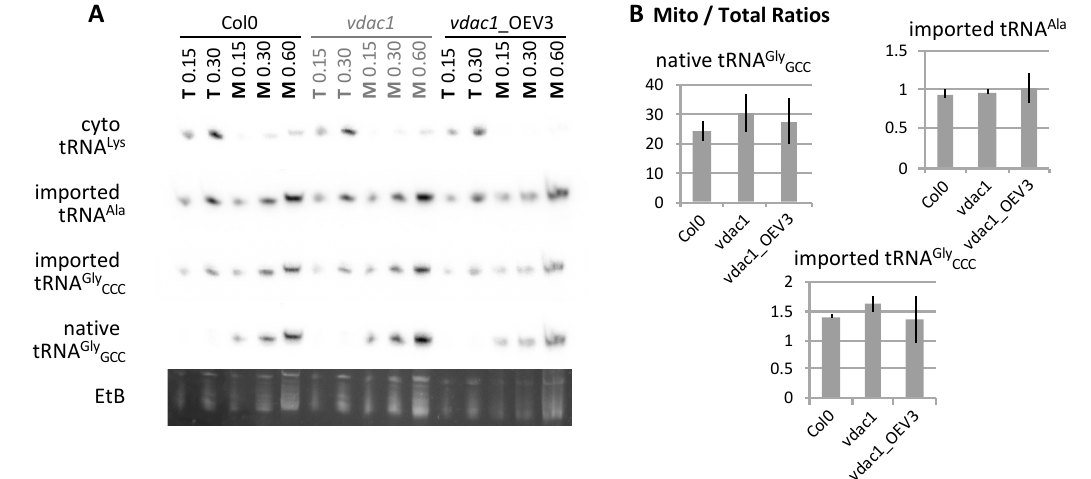
Figure 2. In vivo import of tRNAs into mitochondria. Mitochondria were extracted from Col0, vdac1 and vdac1 _OEV3 seedlings. Total (T) and mitochondrial (M) tRNAs were prepared and loaded onto a urea-polyacrylamide gel (0.15–0.60 µ g). ( A ) Northern blots. Four tRNA probes were used. The native tRNA Gly corresponds to a mitochondrial-encoded tRNA. The tRNA Ala and tRNA Gly CCC are nuclear-encoded and imported into mitochondria. The tRNA Lys is nuclear-encoded, but restricted to the cytosol [24]. This last probe shows that the level of cytosolic contamination is low in mitochondria from every plant line. EtB, ethidium bromide staining. ( B ) Quantification. Two similar blots were performed and the signals were quantified. The M / T ratios were calculated for loadings of 0.15 and 0.3 mg of total and mitochondrial RNAs, respectively. Imported tRNA Ala and native tRNA Gly , N = 4; imported tRNA Gly , N = 2. Error bars, SEM.